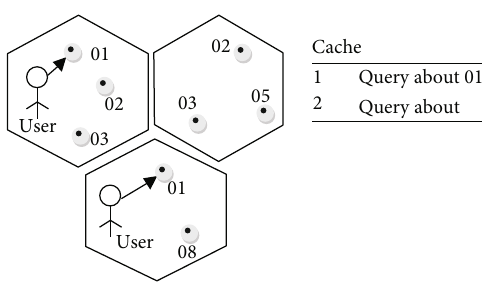
Figure 2: Mobile client static objects.